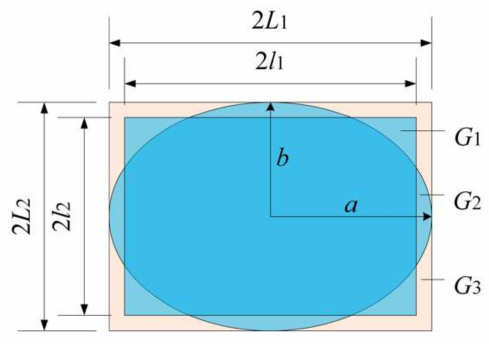
Figure 5. Gaussian bell load: ( a ) load distribution function, ( b ) Fourier transform.